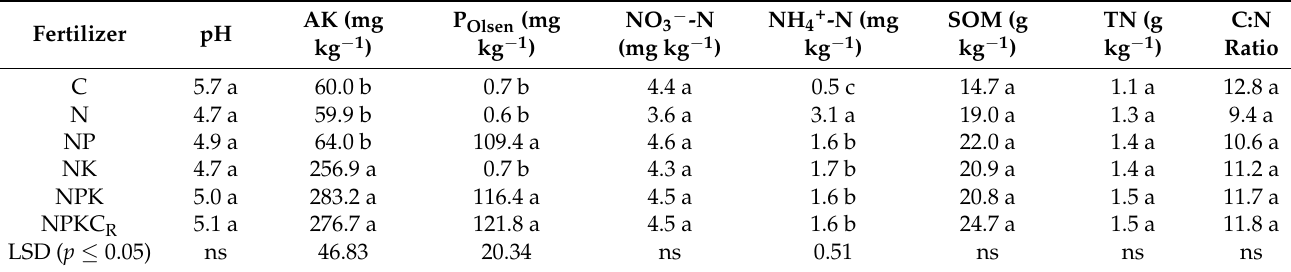
Table 1. Soil chemical properties of the 0–20 cm soil layer as a function of the applied fertilization. Average values of 1991–2010 (before liming).